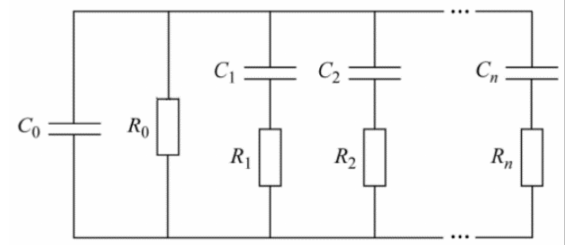
Figure 3. Extended Debye